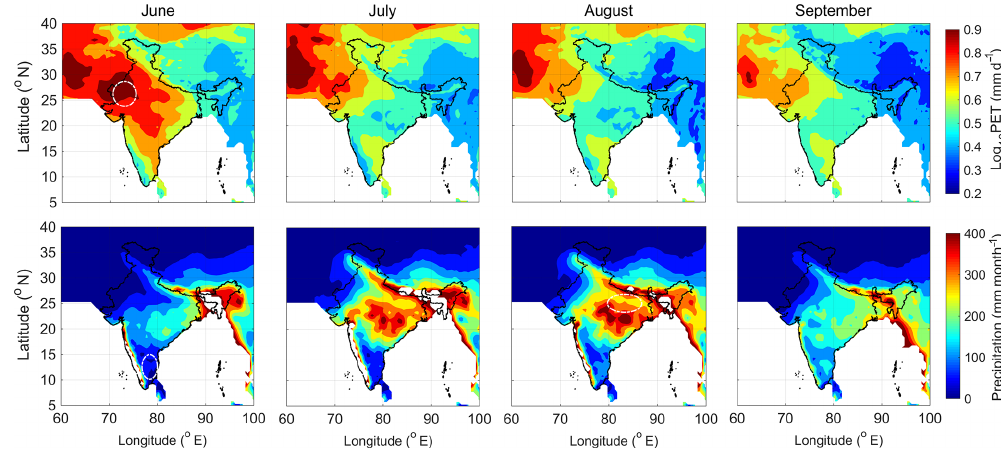
Figure 1. Monthly averaged maps of potential evapotranspiration rate and precipitation during June–September.